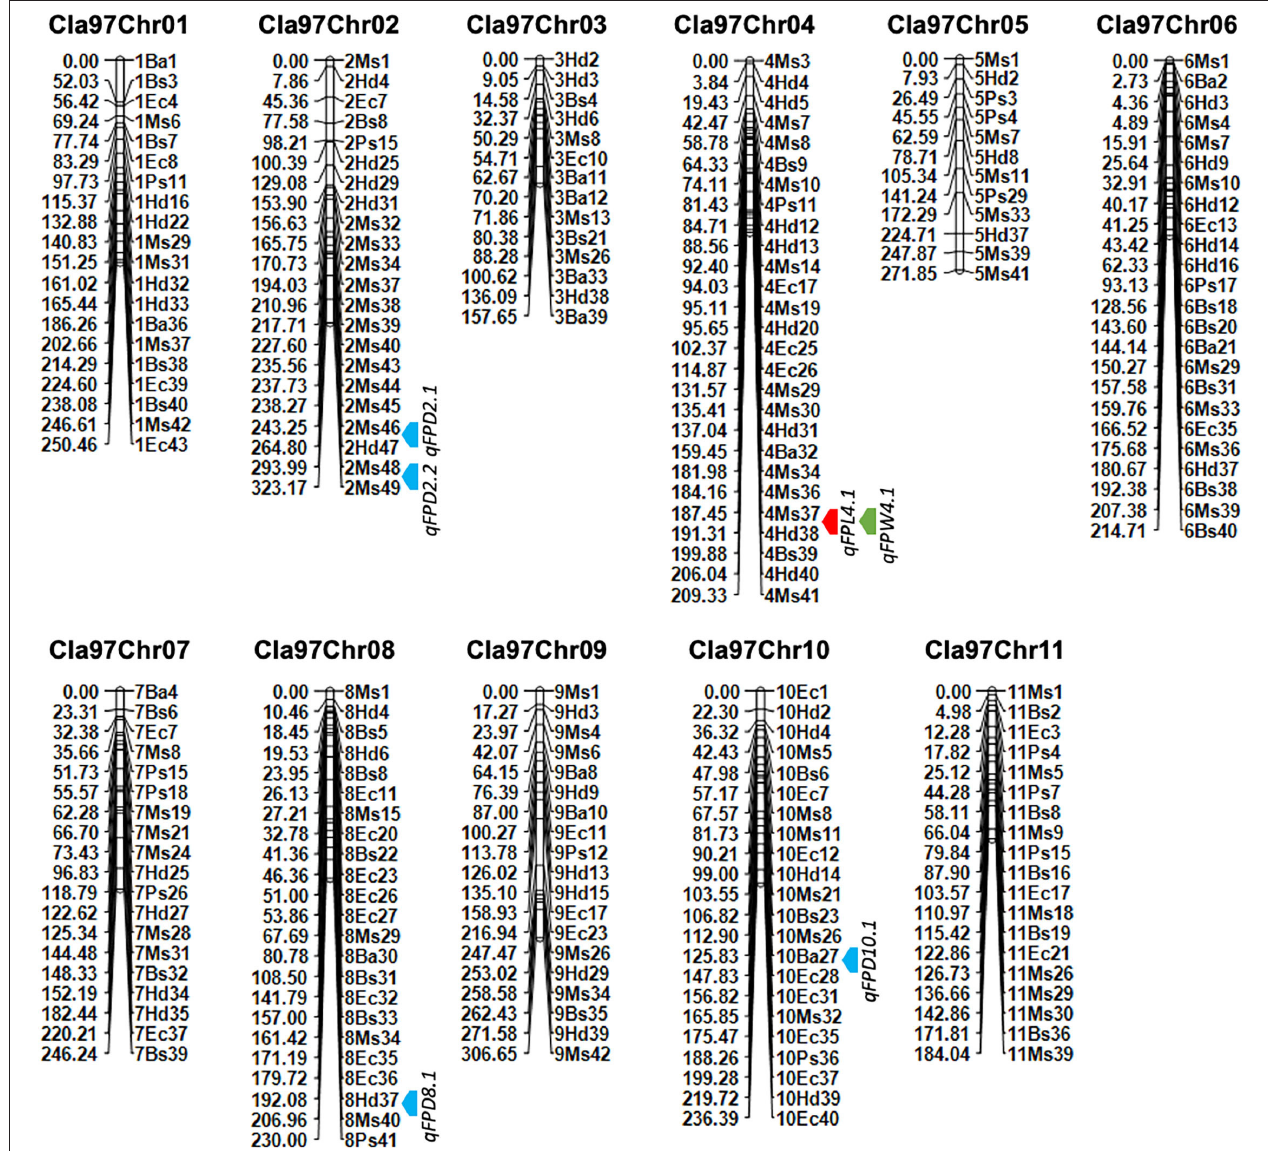
FIGURE 5 | A developed genetic map of watermelon based on genotyping of novel 221 SNP-CAPS markers within F 2 mapping individuals. The bold color arrows (red, blue, and green) indicate the mapped QTL regions. Marker’s positions are aligned on the right side and their genetic positions are aligned on the left side of each chromosome,